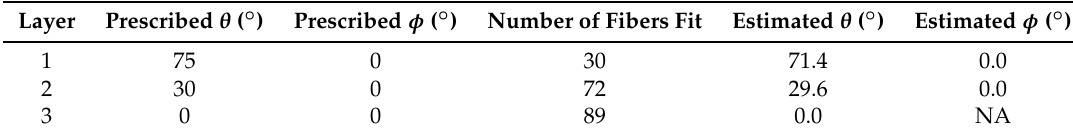
Table 4. Generated volume fiber orientations.